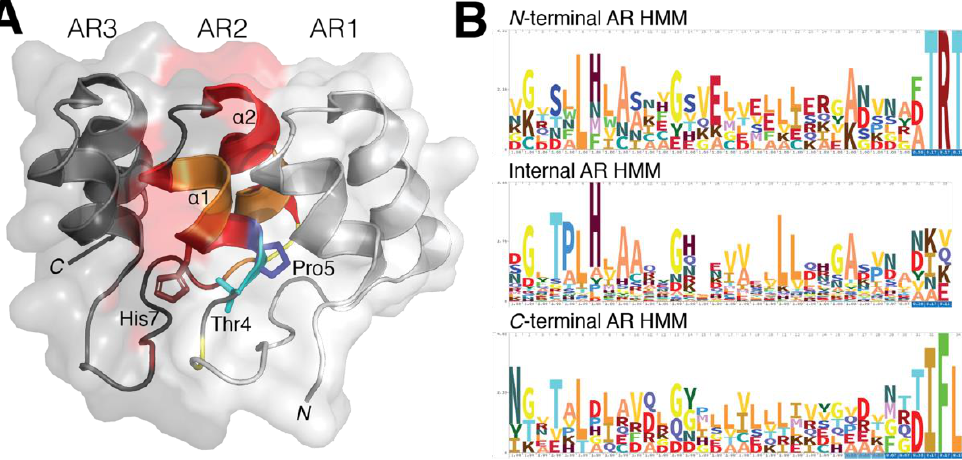
Figure 1. Structural conservation within ankyrin repeat domains. ( A ) Residues Thr4, Pro5 and His7 play a critical role in providing both the 90 ◦ and L-shape formation through hydrogen bonding. The elongated solenoid shape of an AR domain is predominantly dictated by these three residues while hydrophobic interactions in the core of the AR are required to stabilize the domain’s 3D fold. ( B ) The hidden Markov model (HMM) profile of the AR-containing proteins for N- terminal, internal and C -terminal repeats were analyzed to highlight the occurrence of residues in identified AR domain families. The classic G-X-TPLHLA motif was readily identified to have a strong probability of occurring in these AR-containing proteins, whereas in both N - and C -terminal repeats were observed to contain only portions of this motif. While conservation within AR domains is more prevalent within the internal and C- terminal repeats, the N- terminal AR still retains similar AR domain characteristics.